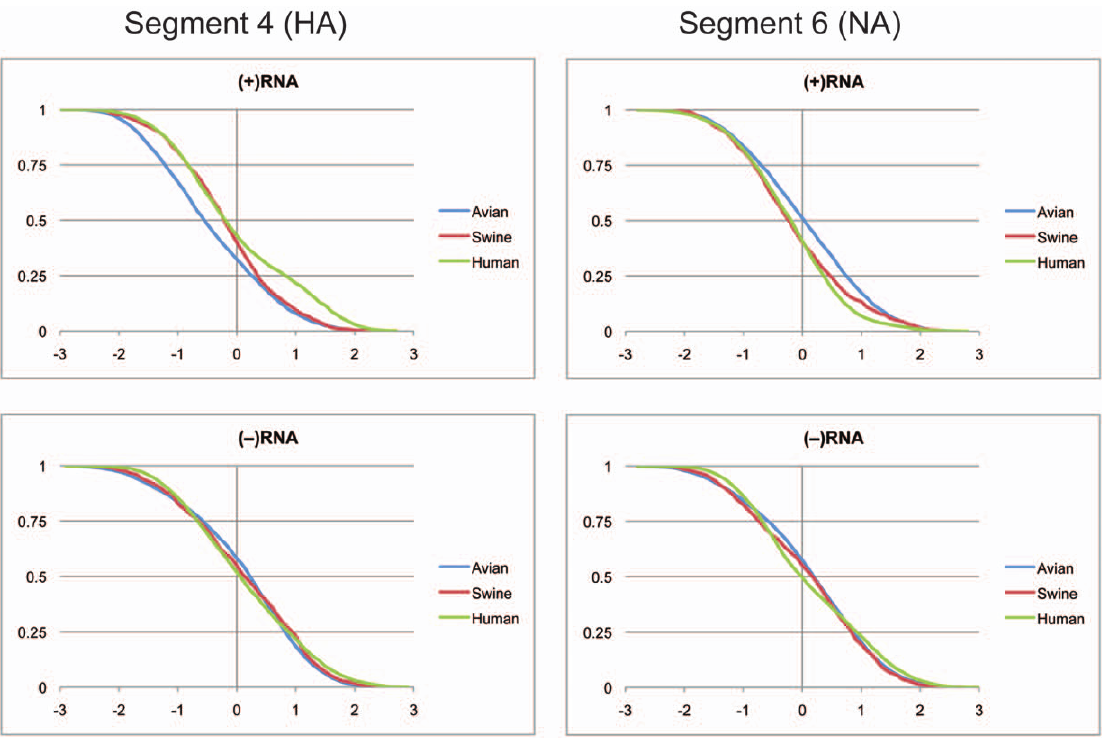
Figure 3. Cumulative distribution plots of z-scores for segments 4 and 6. ( + )RNA and ( 2 )RNA are shown in the top and bottom panels, respectively. See Figure 1 for annotations and details.